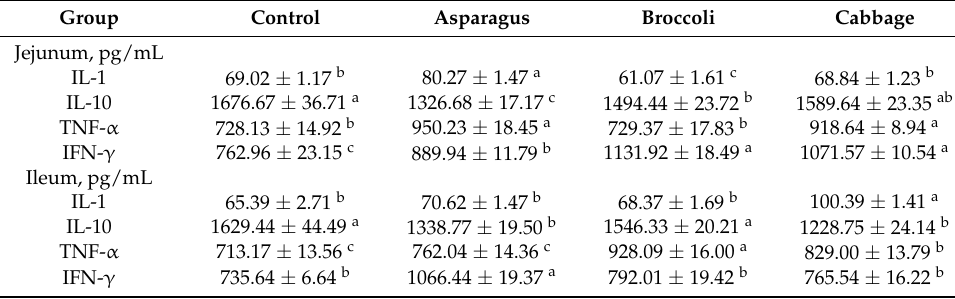
Table 3. Effects of vegetable powder on intestinal cytokine concentrations of